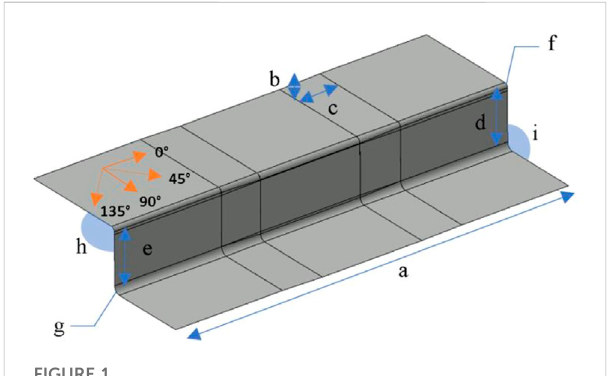
FIGURE 1 Geometry used for forming trials.